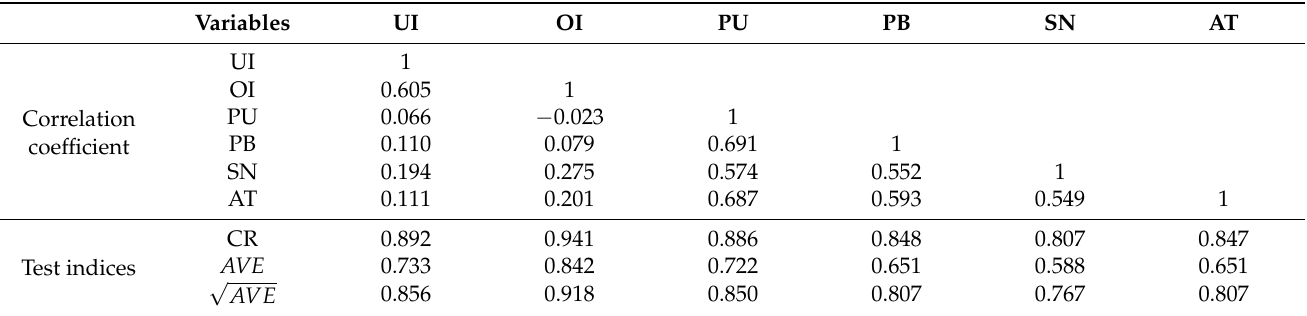
Table 2. Reliability and validity